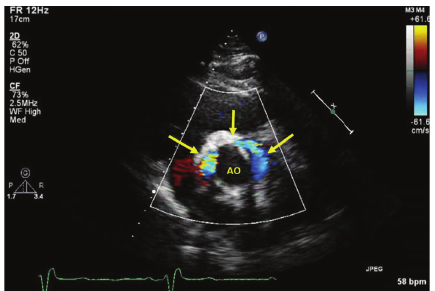
Figure 1: Transthoracic echocardiography revealing a shunt between the aortic root and the right heart involving the right atrium.